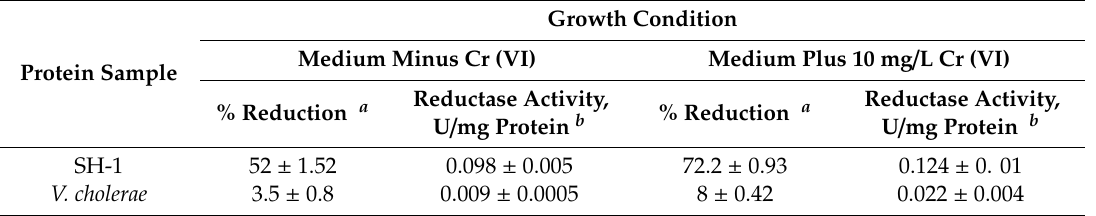
Table 1. Cr (VI) reductase activity of cell-free extracts of the isolate SH-1.